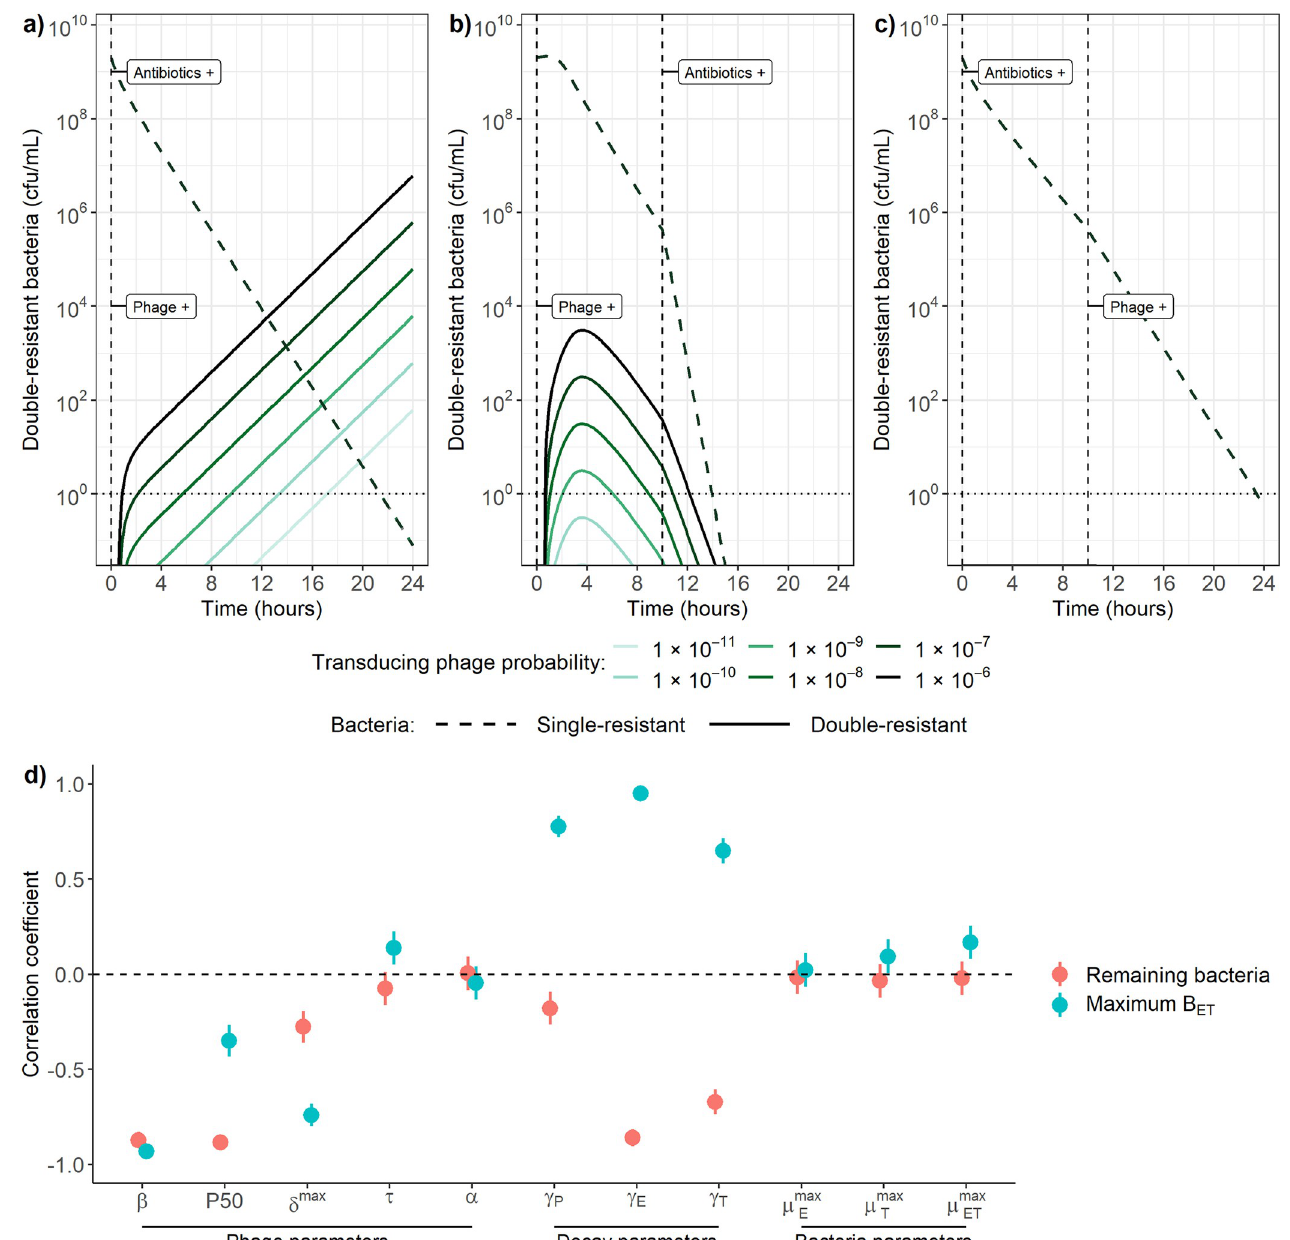
Fig 6. Sensitivity of phage-bacteria dynamics to changes in model parameters. Effect of varying the transduction probability between 10 − 10 and 10 − 6 when a) antibiotics and phage are present at the start of the simulation, b) phage are present at the start, antibiotics are introduced 10h later, and c) antibiotics are present at the start, phage are added 10h later. Transduction probability is defined as the probability that a transducing phage carrying an AMR gene is released instead of a lytic phage during bacterial burst. The dashed lines for single-resistant bacteria overlap and cannot be distinguished. Vertical dashed lines indicate timing of addition of antibiotics or phage. cfu/mL: colony-forming units per mL. d) Partial rank correlation between model parameters, and remaining bacteria after 48h (pink) or maximum double-resistant bacteria (B ET ) concentration (blue). Information on the parameter ranges investigated can be found in Table 1. β : adsorption rate, P50: phage concentration at half saturation, δ max : burst size, τ : latent period, α : transduction probability, γ P : phage decay, γ E : erythromycin decay, γ T : tetracycline decay, μ max E : B E growth rate, μ max T : B T growth rate, μ max ET : B ET growth rate.